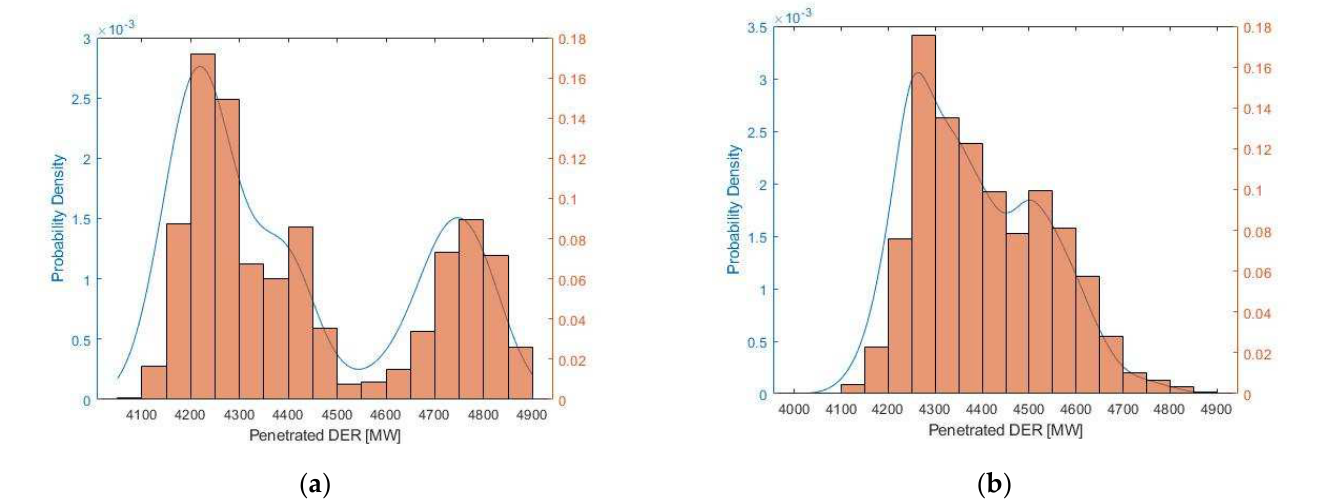
Figure 7. Simulation results of reinforced case: ( a ) P2P case; ( b ) Three-station case.